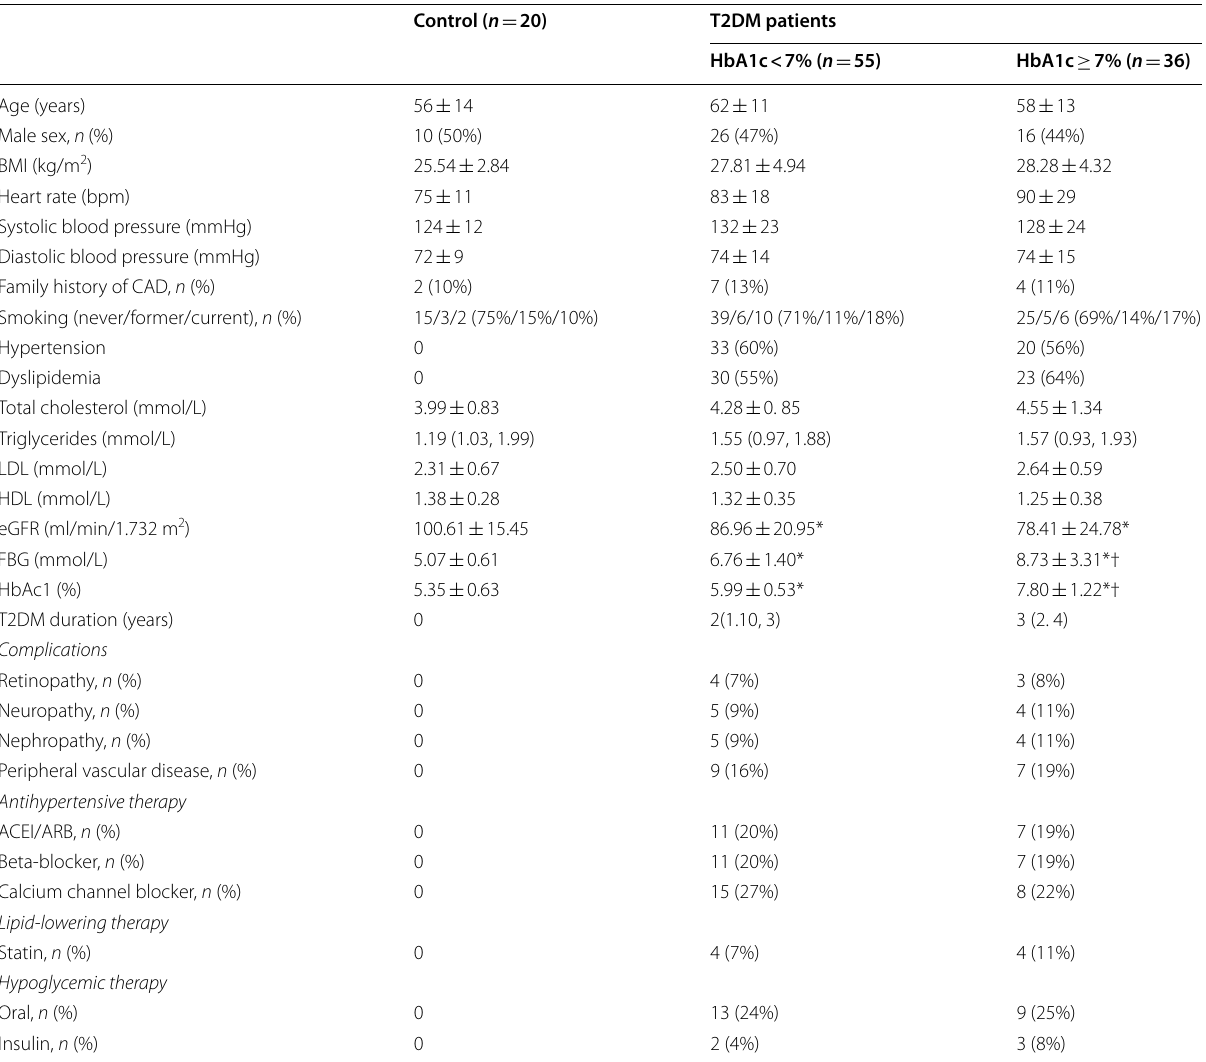
Table1 Baseline characteristics of the study